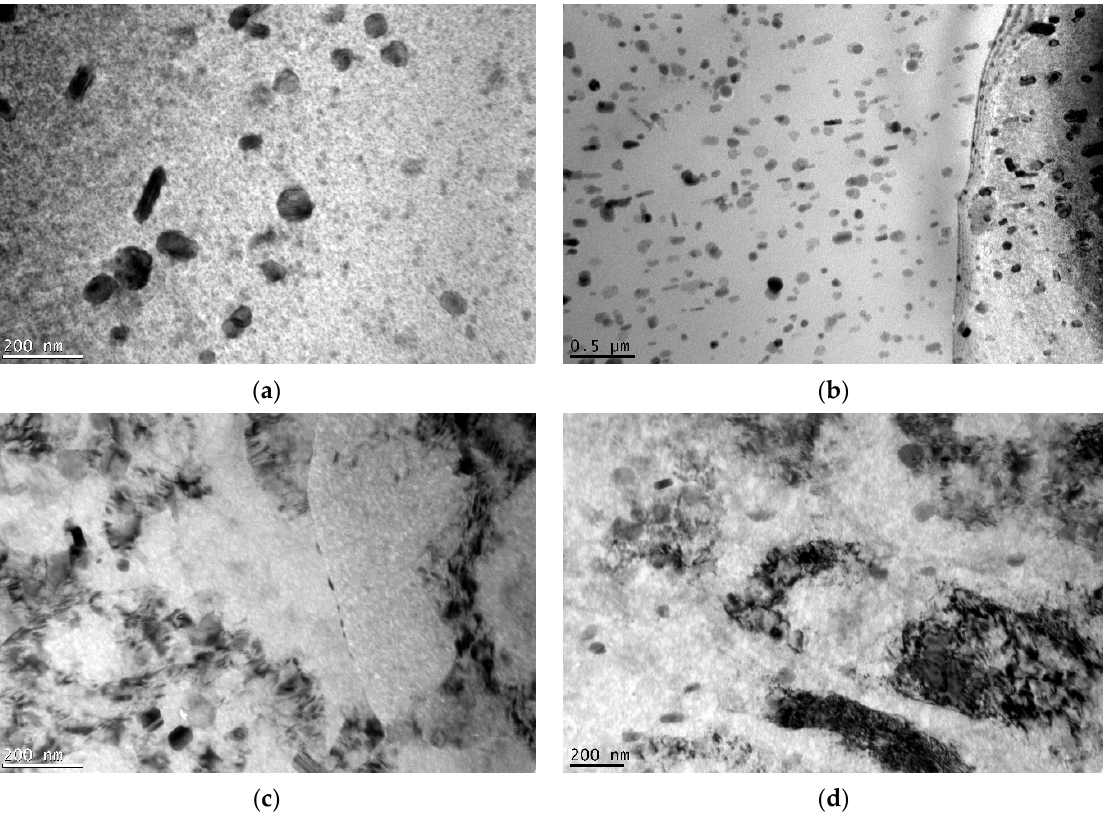
Figure 4. TEM micrographs of the samples: ( a ) transverse plane of CG, ( b ) longitudinal plane of CG, ( c ) transverse plane of HE, and ( d ) longitudinal plane of HE.